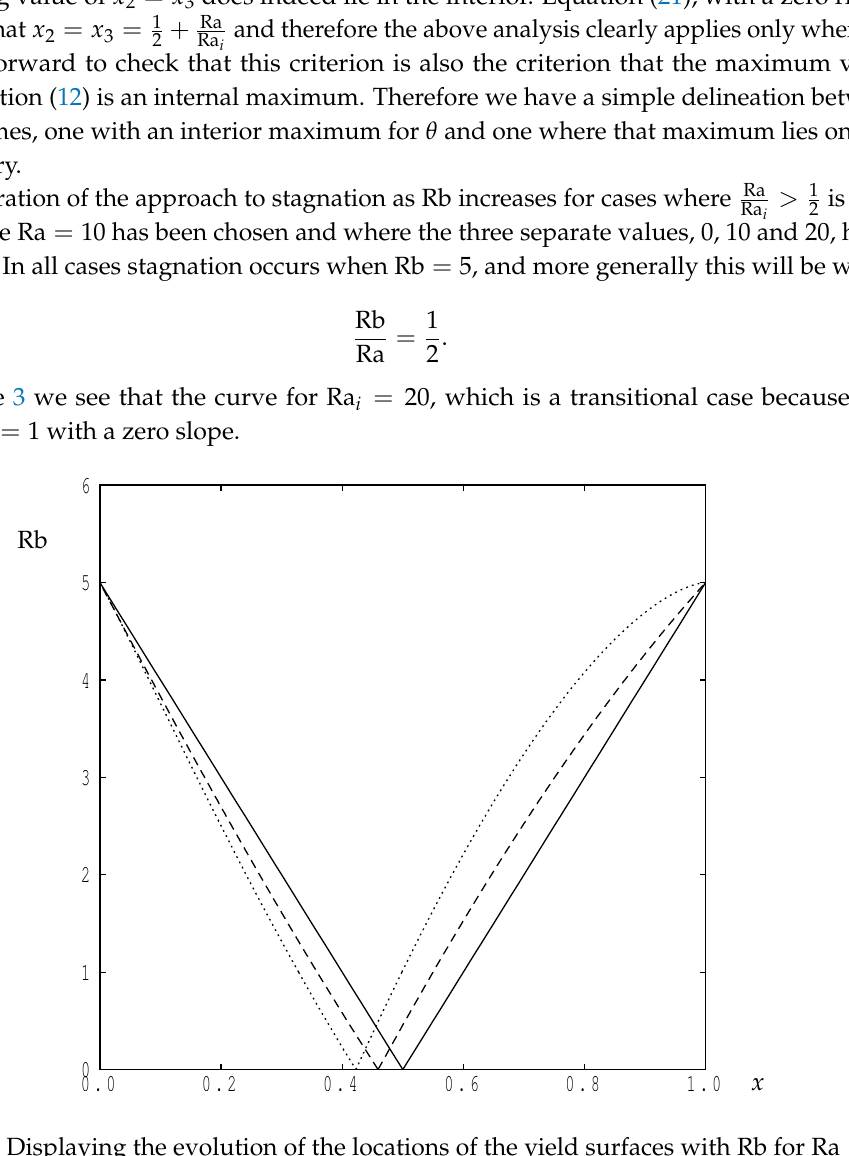
Figure 3. Displaying the evolution of the locations of the yield surfaces with Rb for Ra = 10 and for Ra i = 0 (continuous), Ra i = 10 (dashed) and Ra i = 20